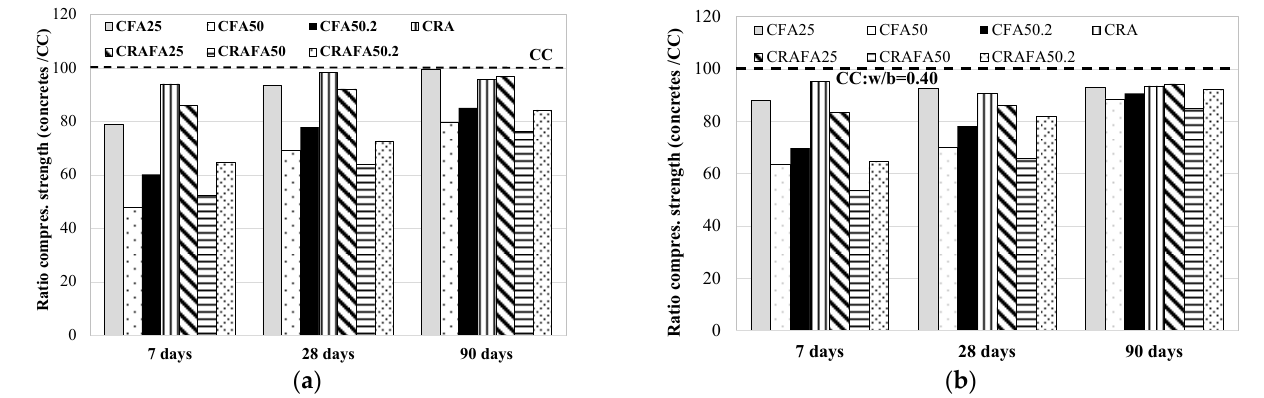
Figure 5. The compressive strength of all concretes with respect to the CC concrete: ( a ) Series 1, ( b ) Series 2.